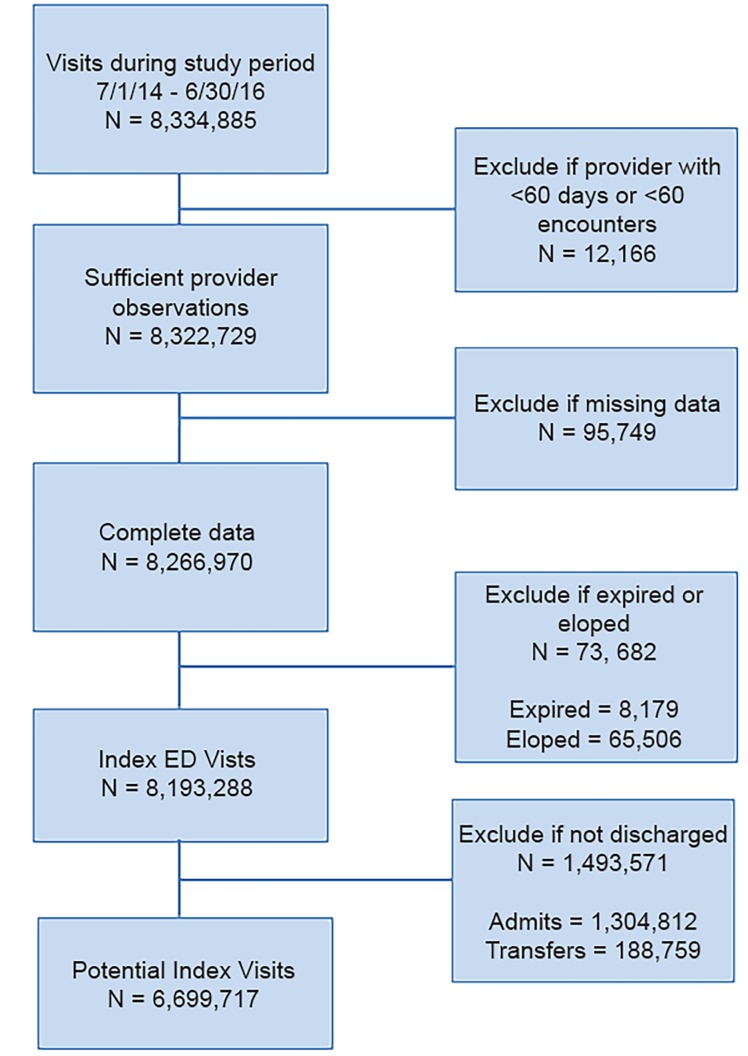
CONSORT-like flow diagram.ED, emergency department.